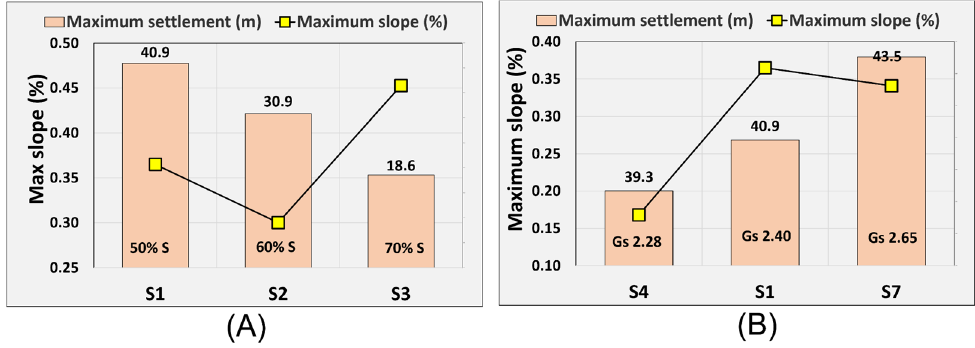
Figure 14. Settlement analysis for different solids contents ( A ) and specific gravity ( B ).